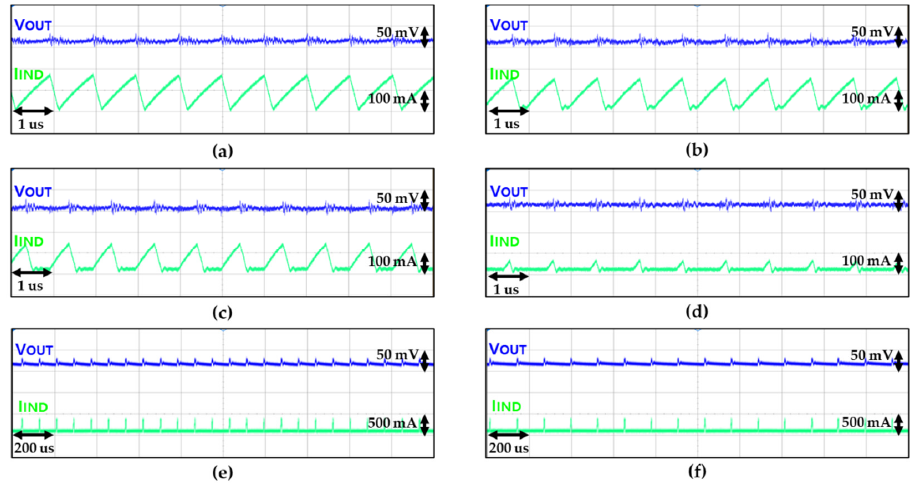
Figure 12. Measured steady-state DC-DC buck operations with respect to load currents of ( a ) PWM 80 mA, ( b ) PWM 60 mA, ( c ) PWM 40 mA, ( d ) PWM 20 mA, ( e ) PFM 10 mA, and ( f ) PFM 5